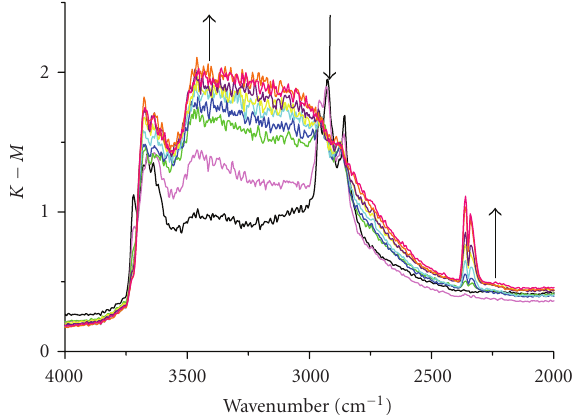
Figure 5: DRIFT spectra taken during the course of 1-hour UV oxidation of decane on TiO 2 under 1 atm O 2 . Arrows indicate increase in surface-bound water and CO 2 vapor, and a decrease in hydrocarbon